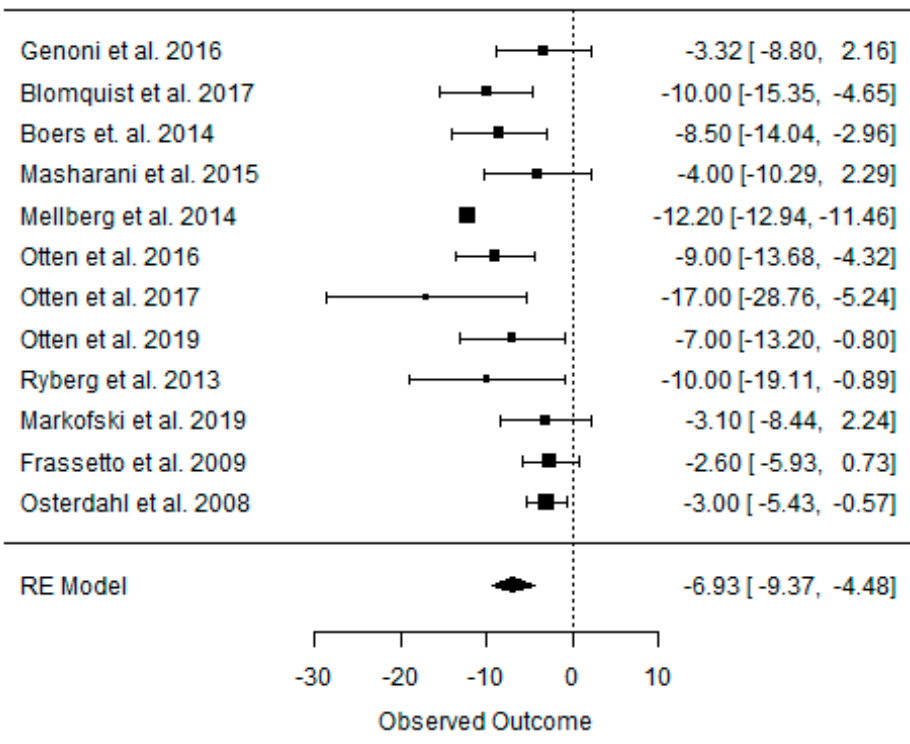
Figure A34. Forest plot of the effect of a PDs on SBP in the short term (weighted mean difference).